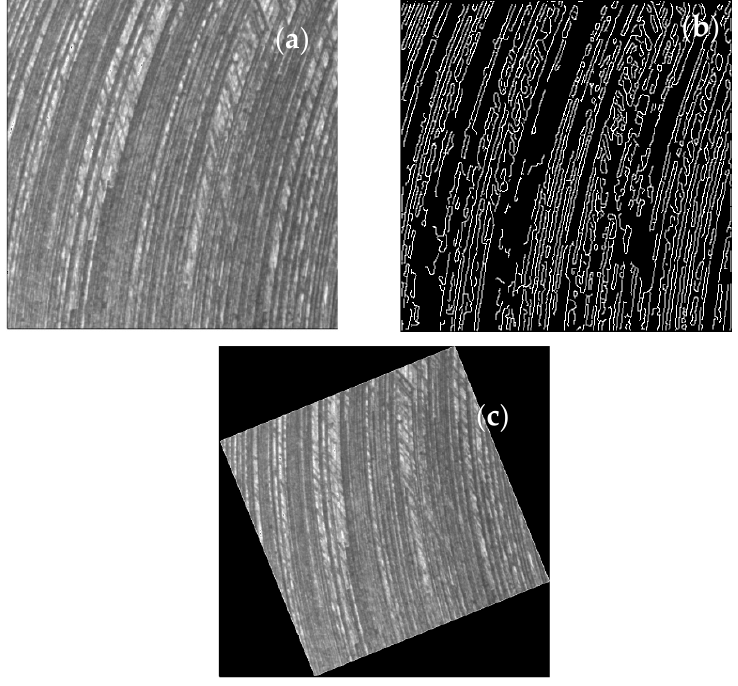
Figure 13. Image skew correction ( a ) original image; ( b ) detected edge and ( c ) adjusted